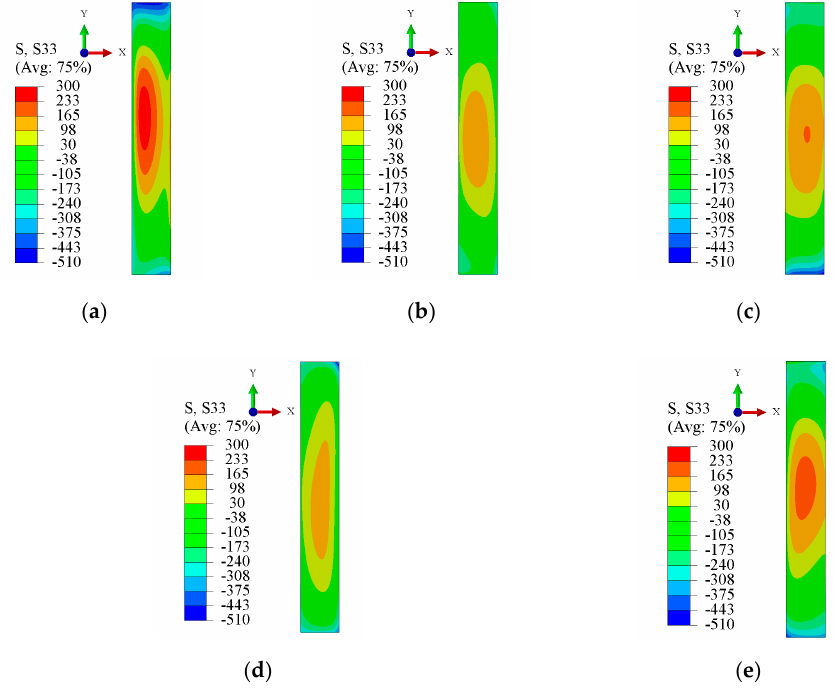
Figure 6. Stress reconstruction on cutting surface of specimens for different cryogenic parameters. ( a ) Specimen #1. ( b ) Specimen #2. ( c ) Specimen #3. ( d ) Specimen #4. ( e ) Specimen #5. Three evaluation lines at the 25%, 50%, and 75% positions along the X-direction